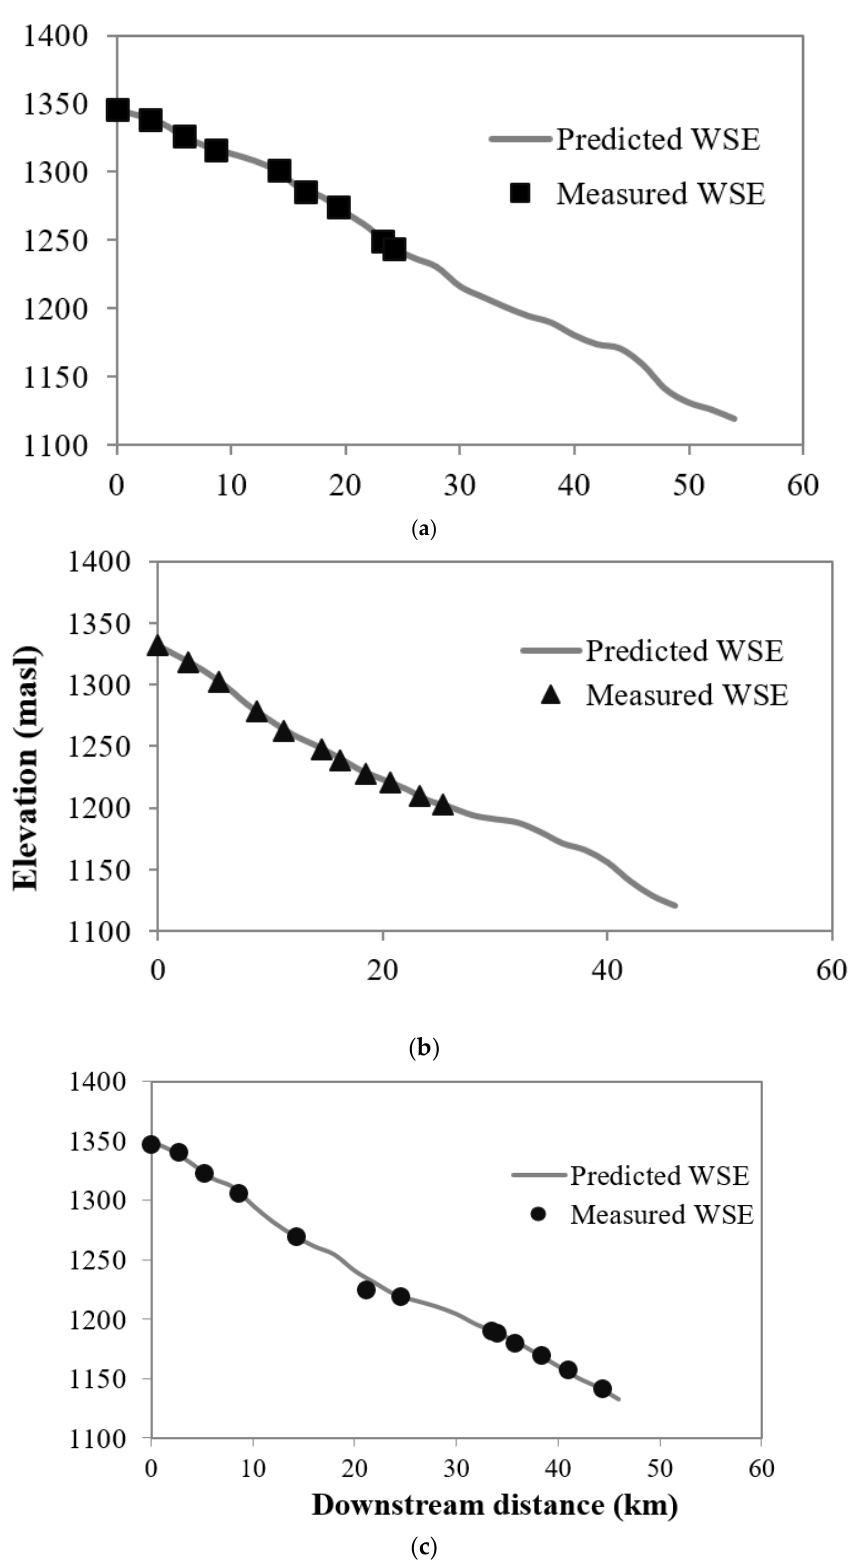
Figure 4. Comparisons between measured and predicted water surface elevations for the Crowsnest River reach (( a ) Flow rate = 2.65 m 3 /s; Manning’s n = 0.070), Castle River reach ( ( b ) Flow rate = 4.0 m 3 /s; Manning’s n = 0.070) and Oldman River reach (( c ) Flow rate = 5.0 m 3 /s; Manning’s n = 0.070).